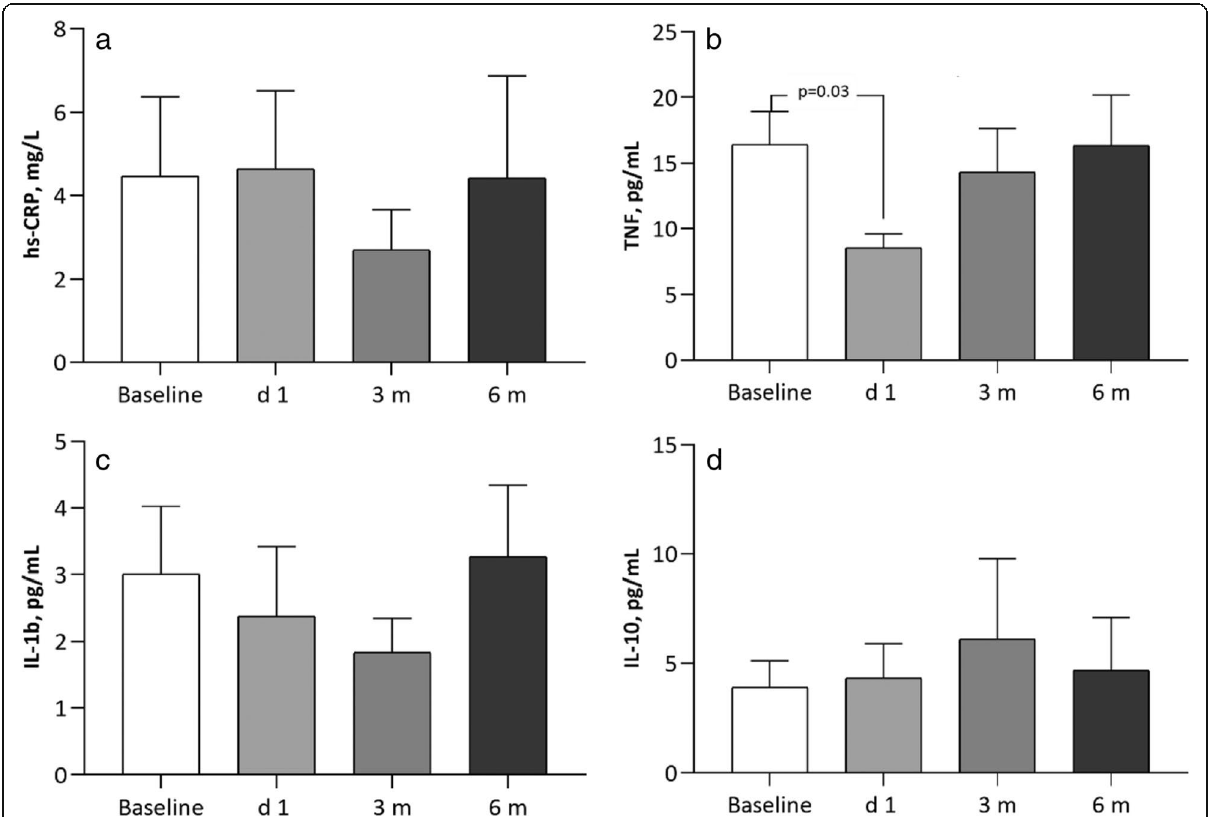
Fig. 1 RDN. Non-stimulated un-incubated levels of inflammatory markers at baseline, 1 day after RDN, and at 3 and 6 months follow up. hsCRP ( a ), TNF ( b ), IL-1b ( c ), IL-10 ( d ). Data presented as median and (10-90)